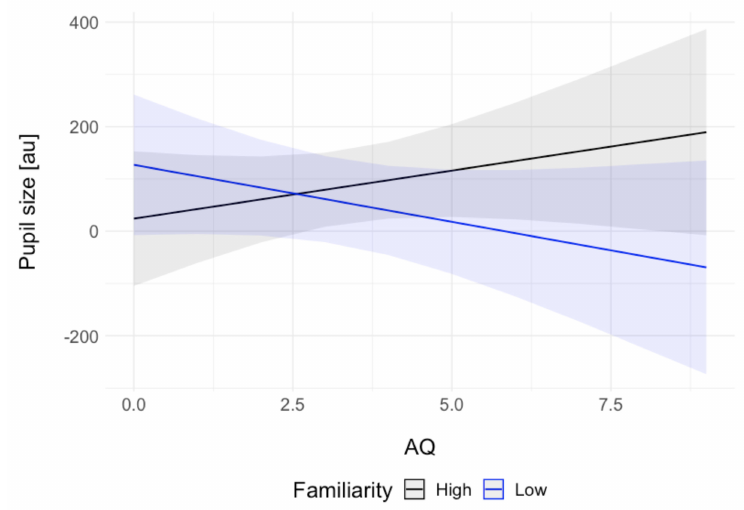
Figure 3. Interaction effects of autistic traits (AQ) and familiarity on pupil size in the passive viewing task. For the purpose of visualisation, the continuous familiarity rating was divided into two factors at value 50 (the range was 1 to 101) into low and high familiarity. The grey areas show 95% confidence